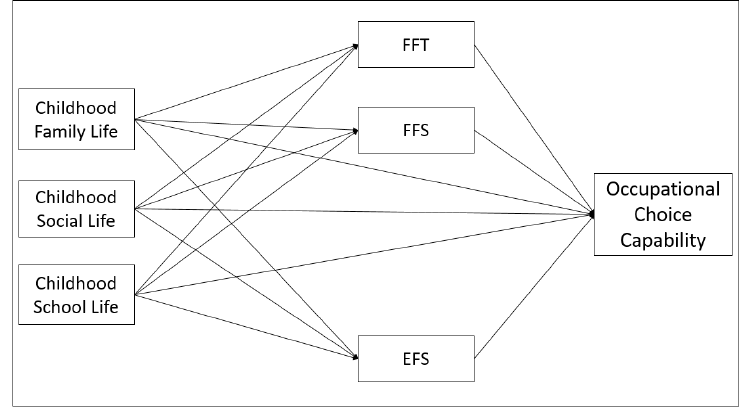
Figure 1. Conceptual Diagram of Model.